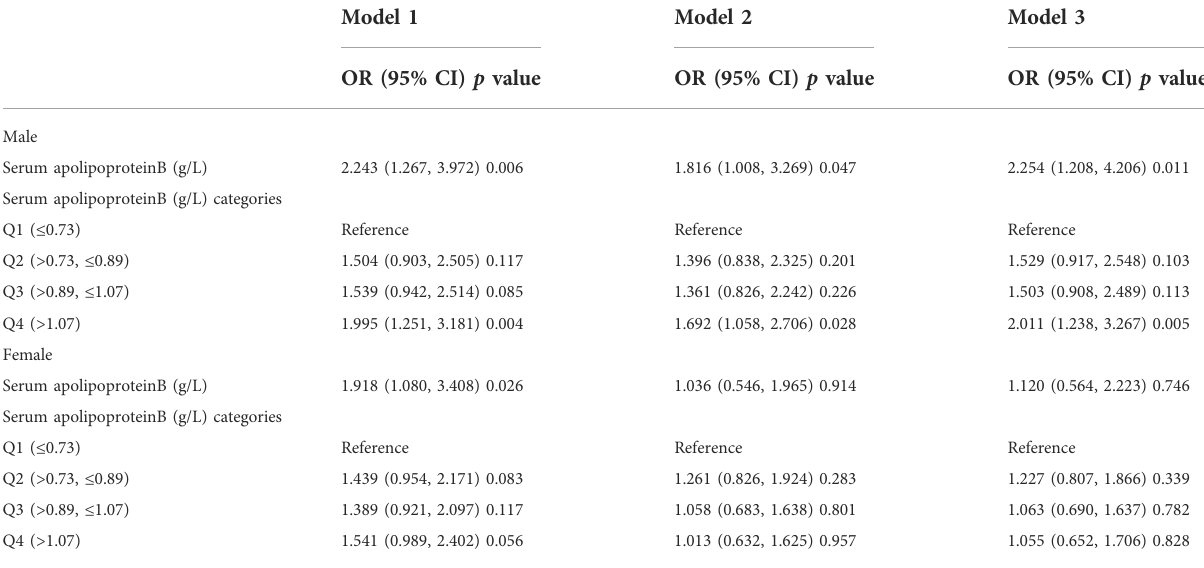
TABLE 7 Association between Serum apolipoprotein B (g/L) and and the risk of osteopenia or osteoporosis. (subgroup analysis strati fi ed by